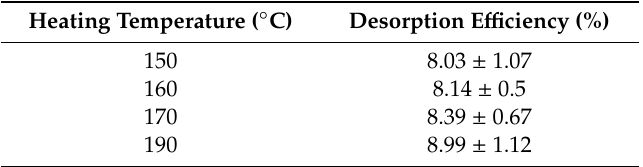
Table 2. Desorption e ffi ciency of the dye at di ff erent heating temperatures.